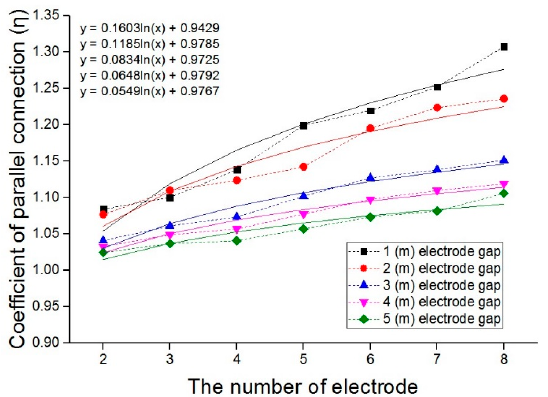
Figure 6. Coefficient of parallel connection vs. the number of electrodes (floating PV system).